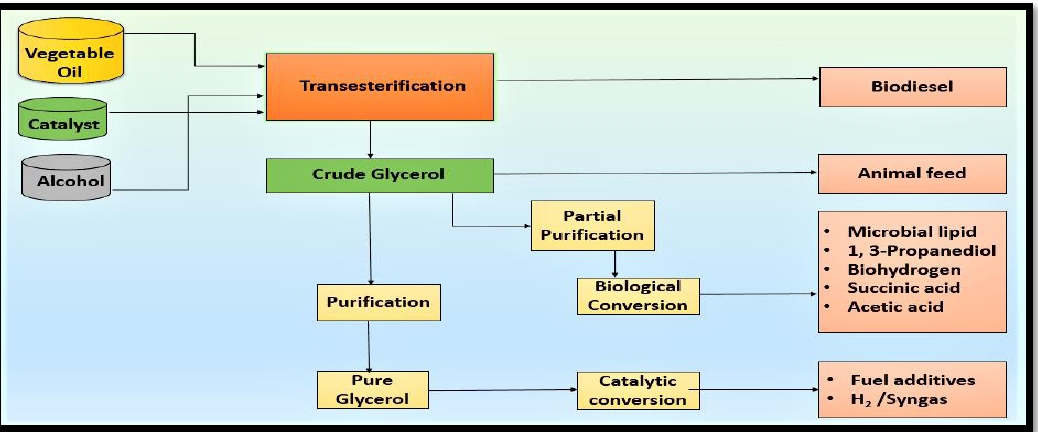
Figure 1. Crude glycerol valorization routes.